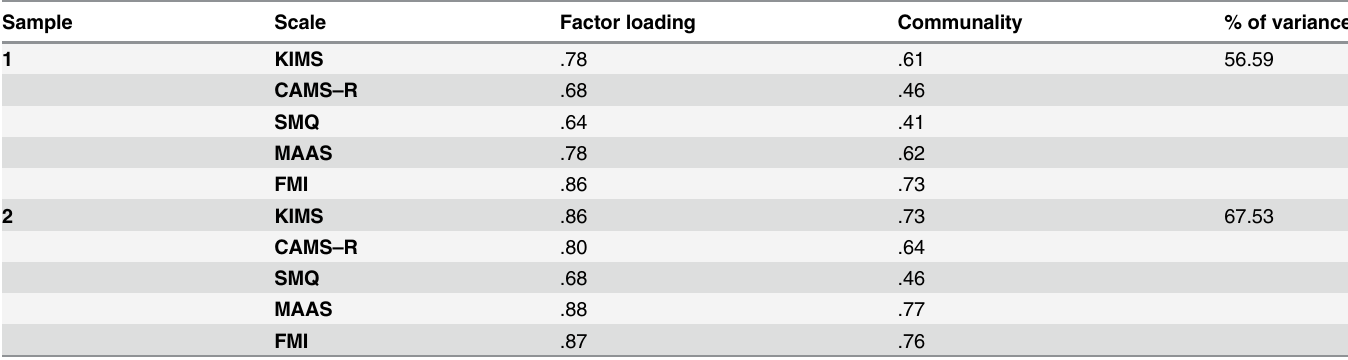
Table 3. Principal Component Analysis of Mindfulness